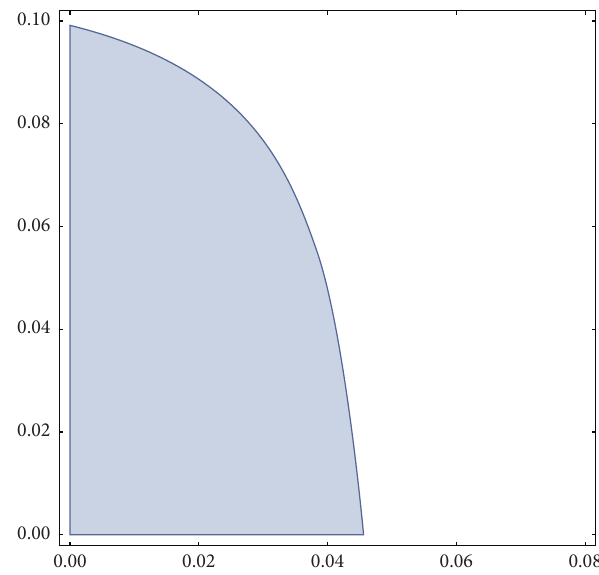
Figure 2: The stable region with the change of β